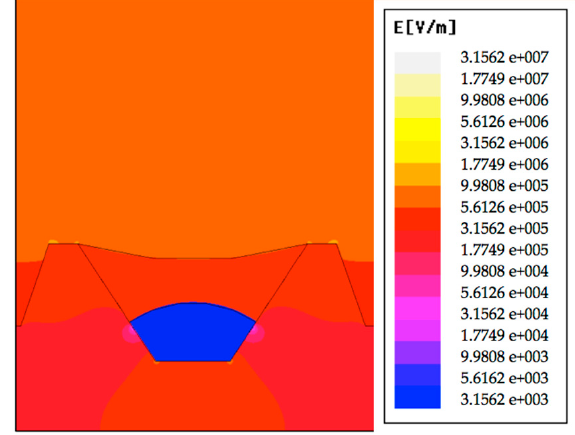
Figure 6. Electric field intensity simulation for the microbatch plates. A single well is shown for clarity reasons. The false color sequence indicates the intensity of the field.